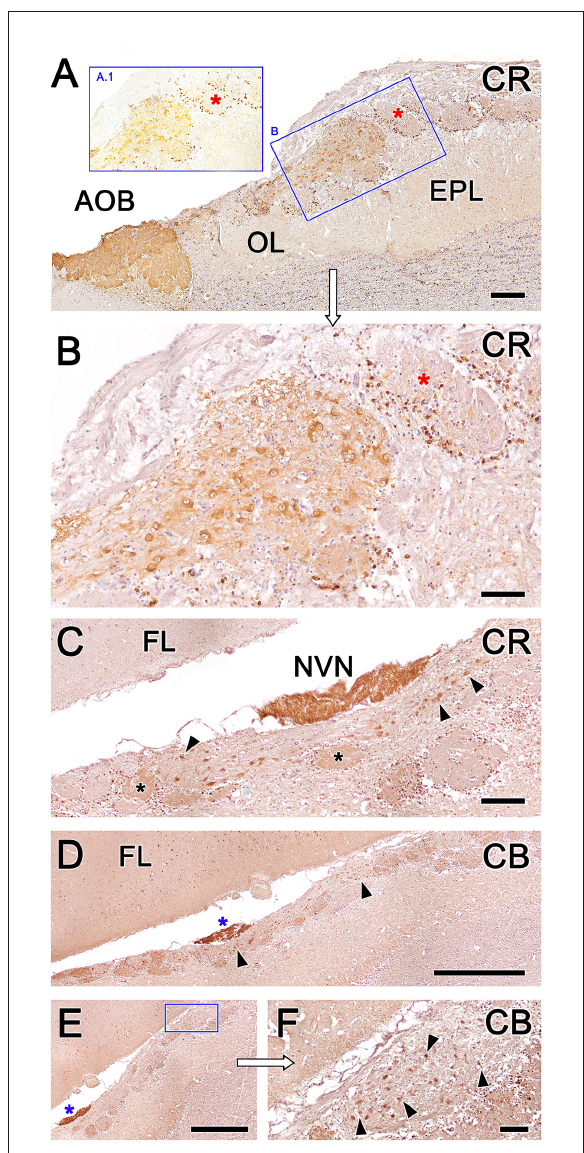
FIGURE10 Fox olfactory limbus (OL) sections immunolabeled with the calcium-binding proteins calretinin (CR) and calbindin (CB) and counterstained with hematoxylin. (A) Anti-CR immunostaining produces intense labeling in the macroglomerular complex (MGC) of the OL (box B ) and in the accessory olfactory bulb (AOB). The glomeruli of the main olfactory bulb (MOB) do not show any immunolabeling in their neuropil (red asterisks), although their periglomerular cells are clearly labeled, which is particularly evident in non-counterstained sections (box A.1 ). (B) A higher magnification image of box (B) from panel (A) . In the MGC, both neuronal somata and the neuropil (asterisk) are immunolabeled with anti-CR. (C) Section at the level of the vomeronasal nerve (NVN) shows intense anti-CR immunopositivity. The atypical nervous formation beneath the NVN is elongated and contains scattered neuronal somata (arrowheads). A subpopulation of glomeruli is CR-positive (asterisks). (D) Anti-CB immunostaining produces a similar pattern to anti-CR immunostaining. The NVN is intensely immunopositive to anti-CB (blue asterisk). The MGC is delimited ( Continued